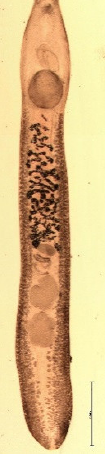
Figure 1. Echinostoma sp. total. Bar: 2 mm.